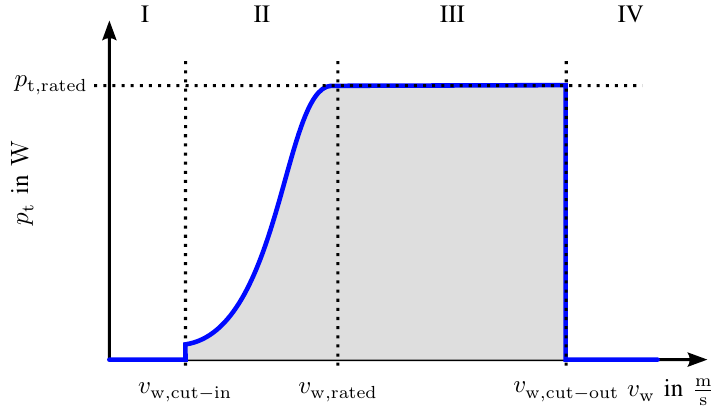
Figure 2. Operation regimes I to IV of a